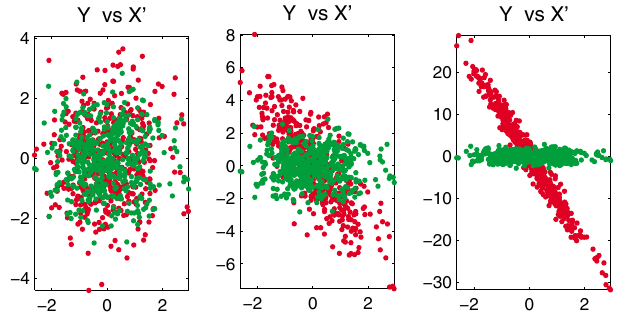
FIG. 8. (Color) Beam phase space at the IP in the tiny detector without (left) and with small additional field (middle, Tiny (cid:1) ; right, Tiny (cid:1) ! ! 1 2